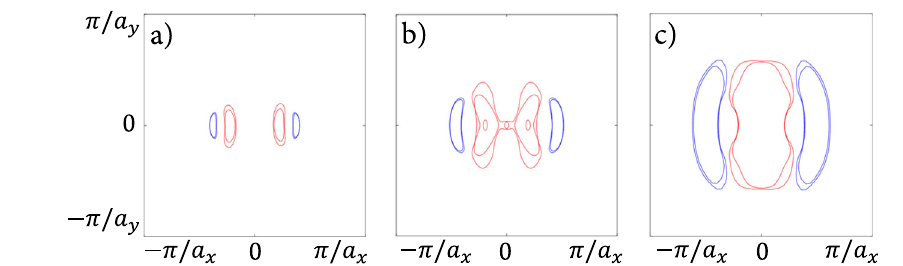
Fig.2|CandidateFermisurfacesforWTe 2 ,withelectron(hole)pocketsinblue (red). a Highly anisotropic pockets, b large pockets, and c very small pockets,